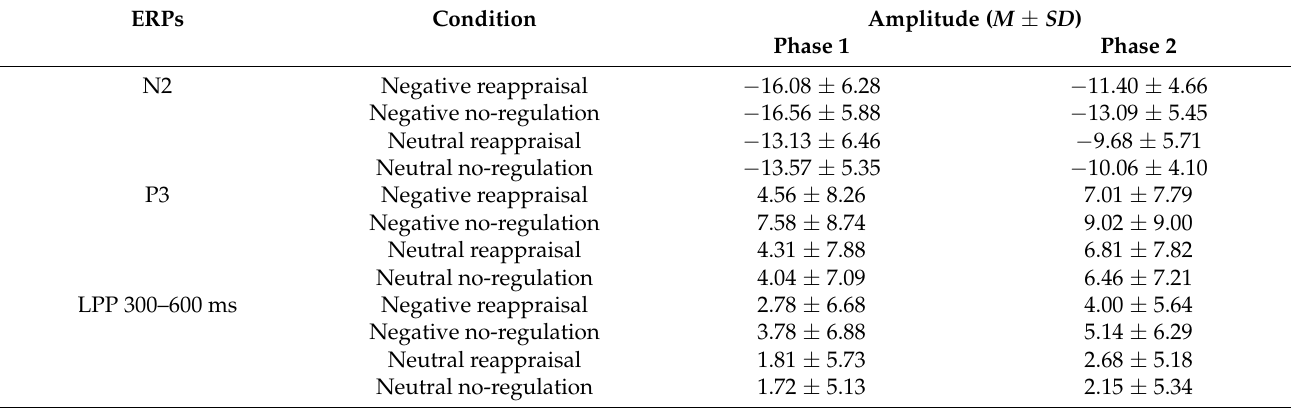
Table 2. Average Amplitudes of Different Components between Different